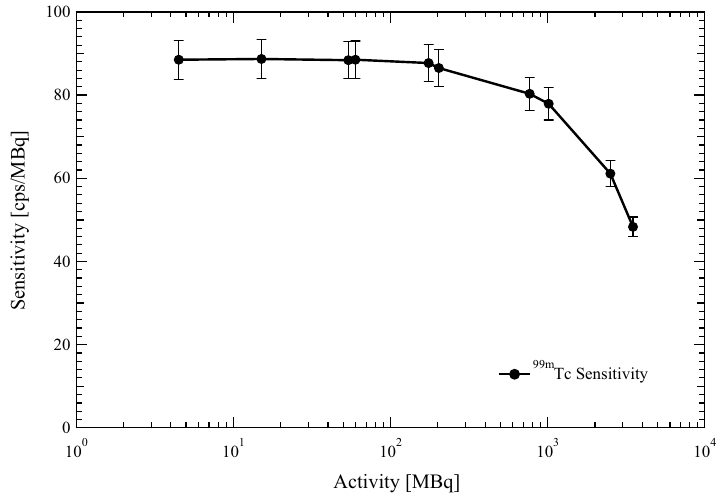
Fig. 3 Planar Sensitivity of 99 m Tc as a function of activity. Plots of 99 m Tc planar sensitivity as a function of